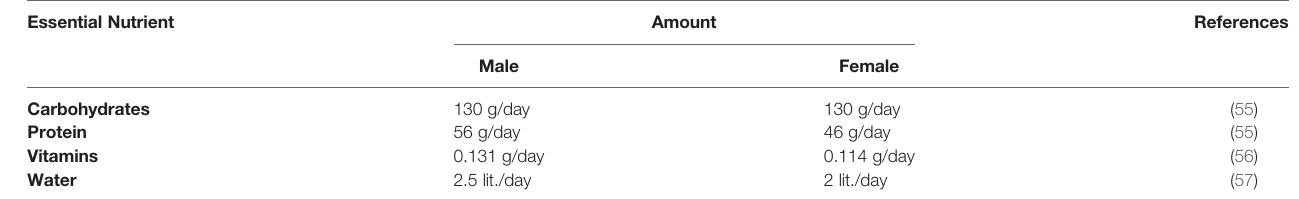
TABLE 1 | Recommended minimum dietary intake of essential nutrients for adults. Essential Nutrient